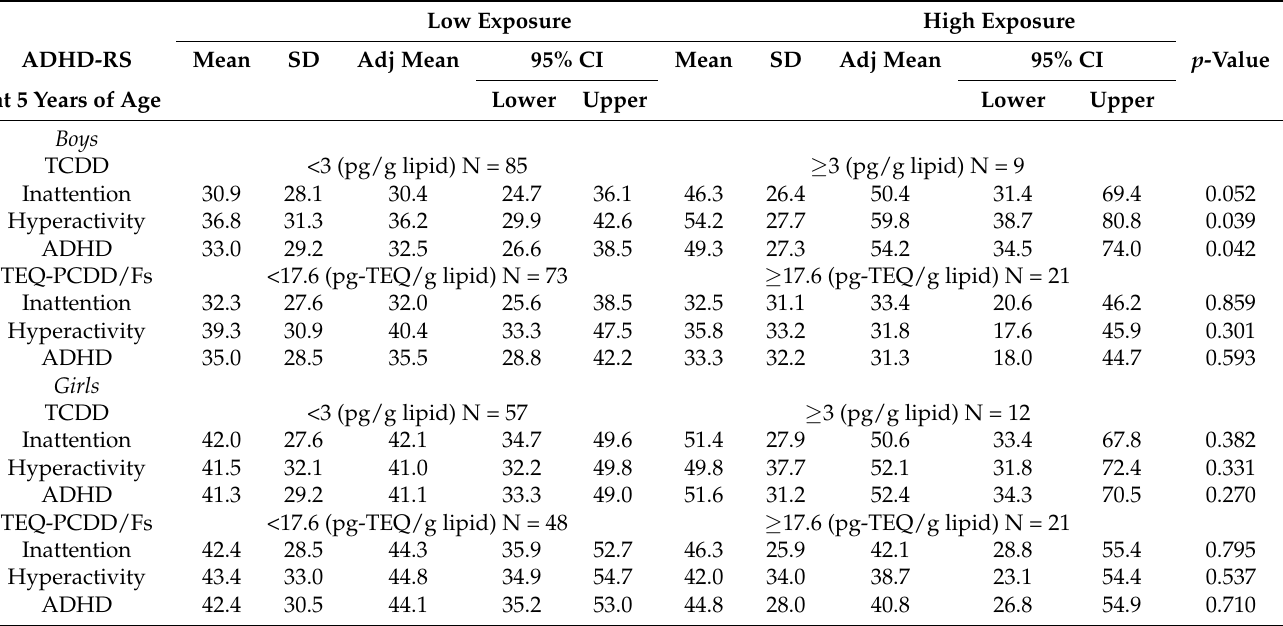
Table 2. Adjusted comparisons of ADHD scores at 5 years of age between high and low expo- sure groups.